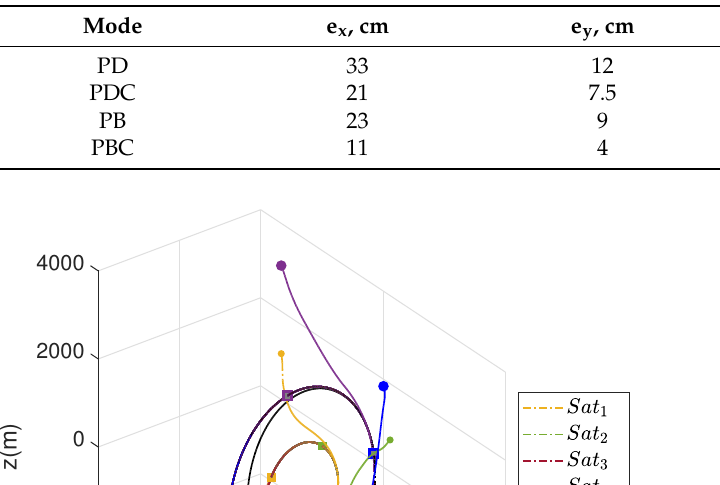
Table 2. Position tracking errors for formation of 8 satellites.